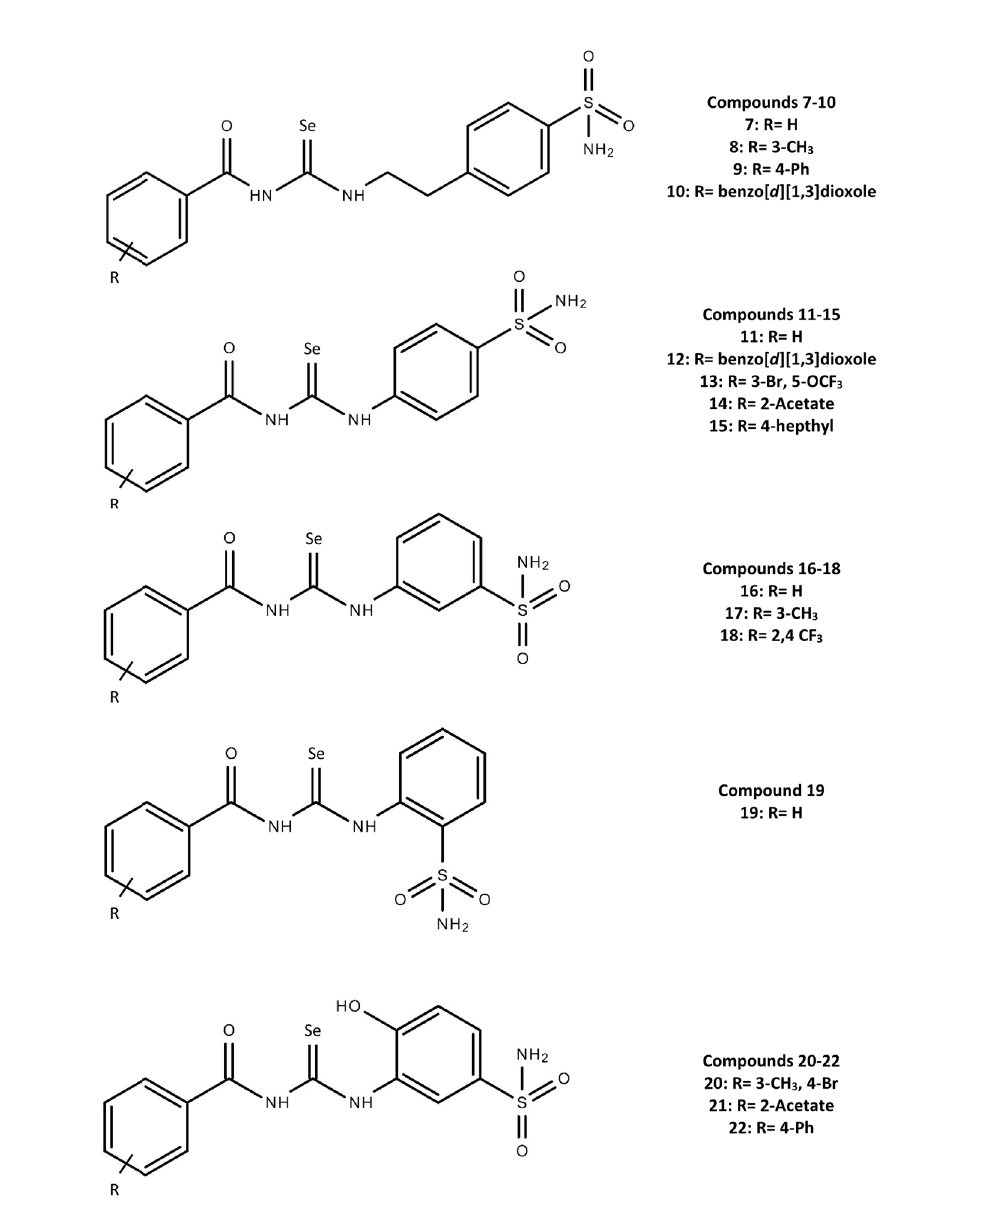
FIGURE 2 - Chemical scaffolds of acyl selenoureido benzensulfonamides as CA